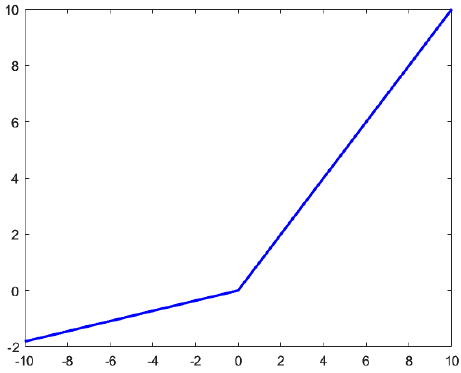
Figure 8. Leaky ReLU activation function ( a i = 5.5).